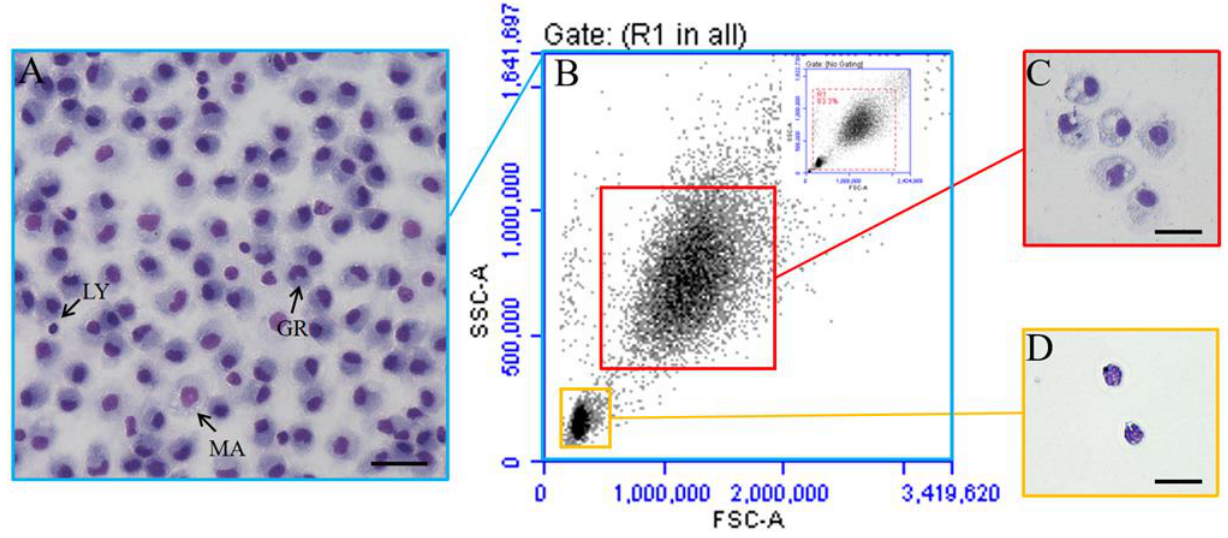
Figure 1. Flow cytometric and Giemsa stain analysis of PerC cells in normal flounder. ( A ) PerC cells were stained with Giemsa. LY: lymphocyte; MA: macrophages; GR: granulocytes. ( B ) Flow cytometric analysis of PerC cells. ( C ) Sorted myeloid cells stained with Giemsa. ( D ) Sorted lymphocytes stained with Giemsa. Bar of both panels: 10 μm.